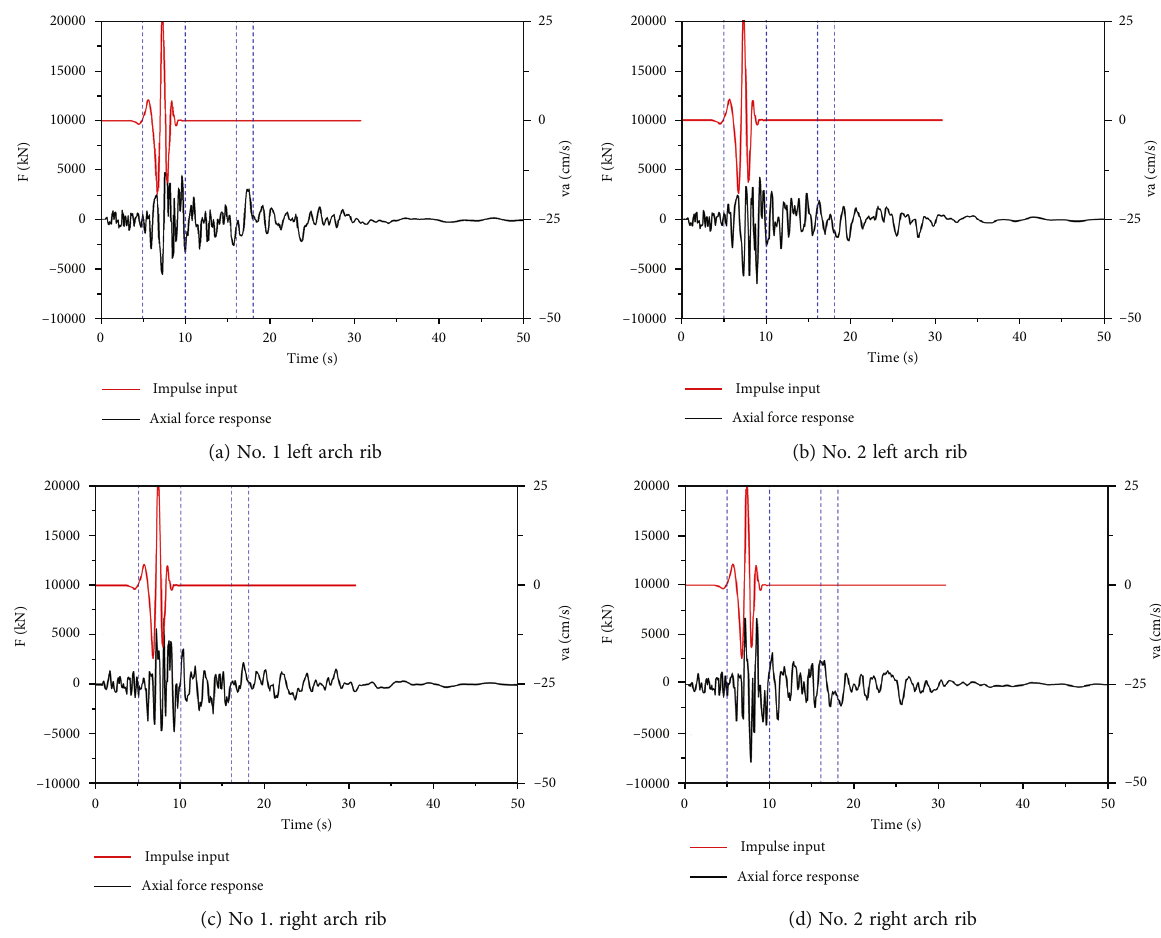
Figure 4: Axial force response of support of the arch with